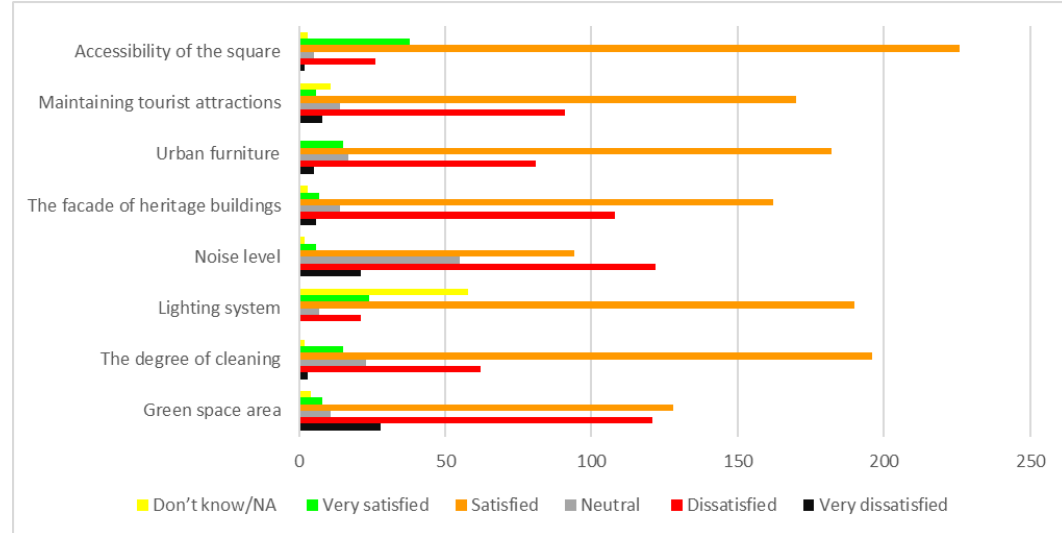
Figure 12: User satisfaction in terms of endowments and functionality of squares